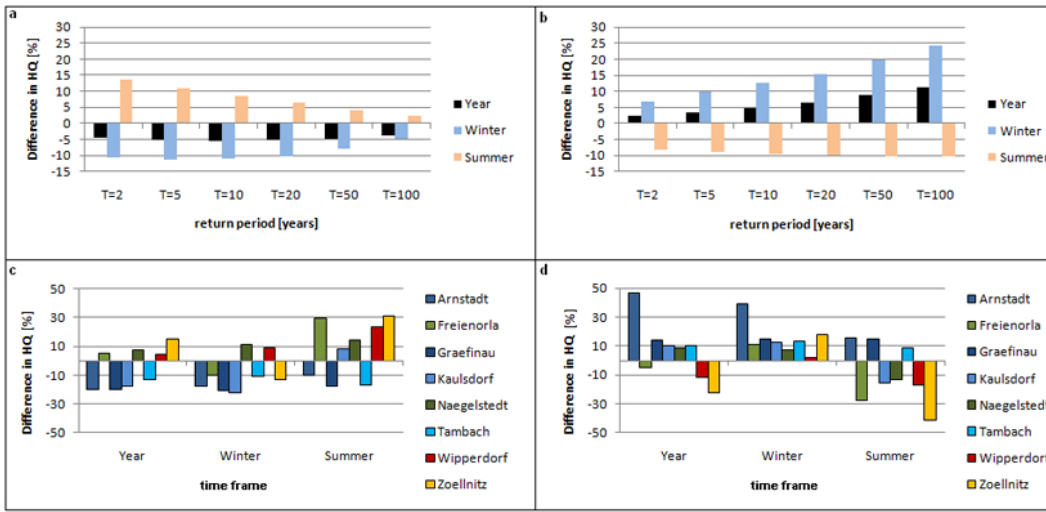
Fig. 4. (a–d) Changes in flood return values for 8 gauges in different time frames (hydrological year, winter, summer) when comparing 2 time periods (TP 1: 1949–1979; TP 2: 1969–1999) to the whole time period (TP all: 1949–1999); upper graphs: mean changes at 6 flood return periods [%] for all gauges in different time frames; lower graphs: mean changes of all flood return values [%] in different time frames at 8 gauges; left side: TP 1, compared to TP all; right side: TP 2, compared to TP